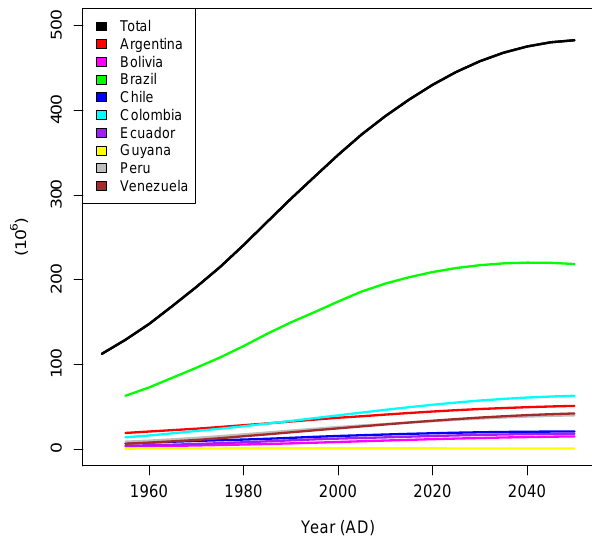
Fig. 2. Observed (until 2007) and predicted population growth for South America by the United Nations (http://esa.un.org/unpd/wpp/ unpp/panel